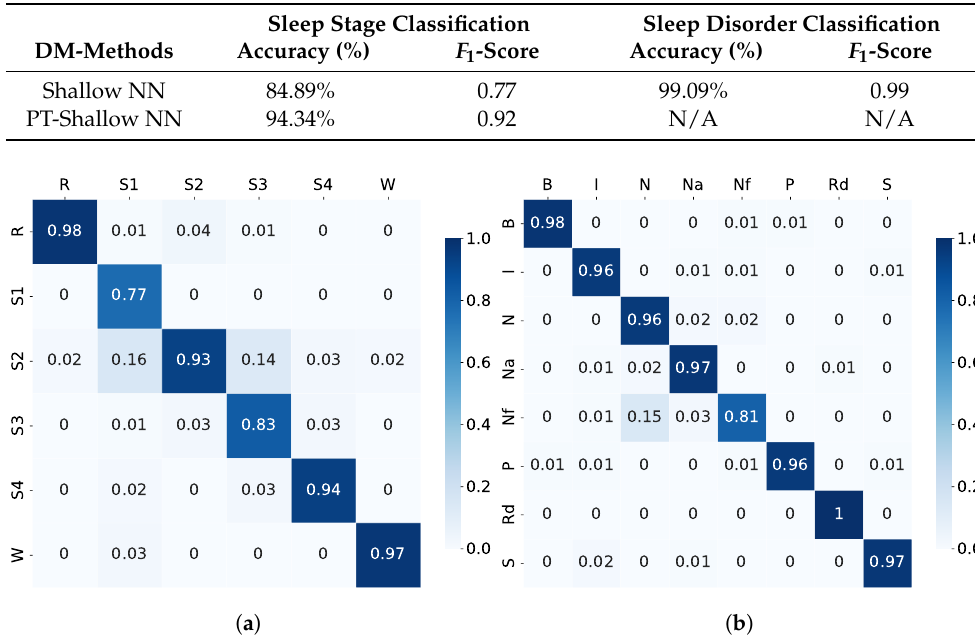
Figure 7. Experiment 3: Examples of confusion matrices for ( a ) sleep stage using MML-DMS2 with pre-trained NN and ( b ) sleep disorder detection using MML-DMS2 with trained-from-scratch